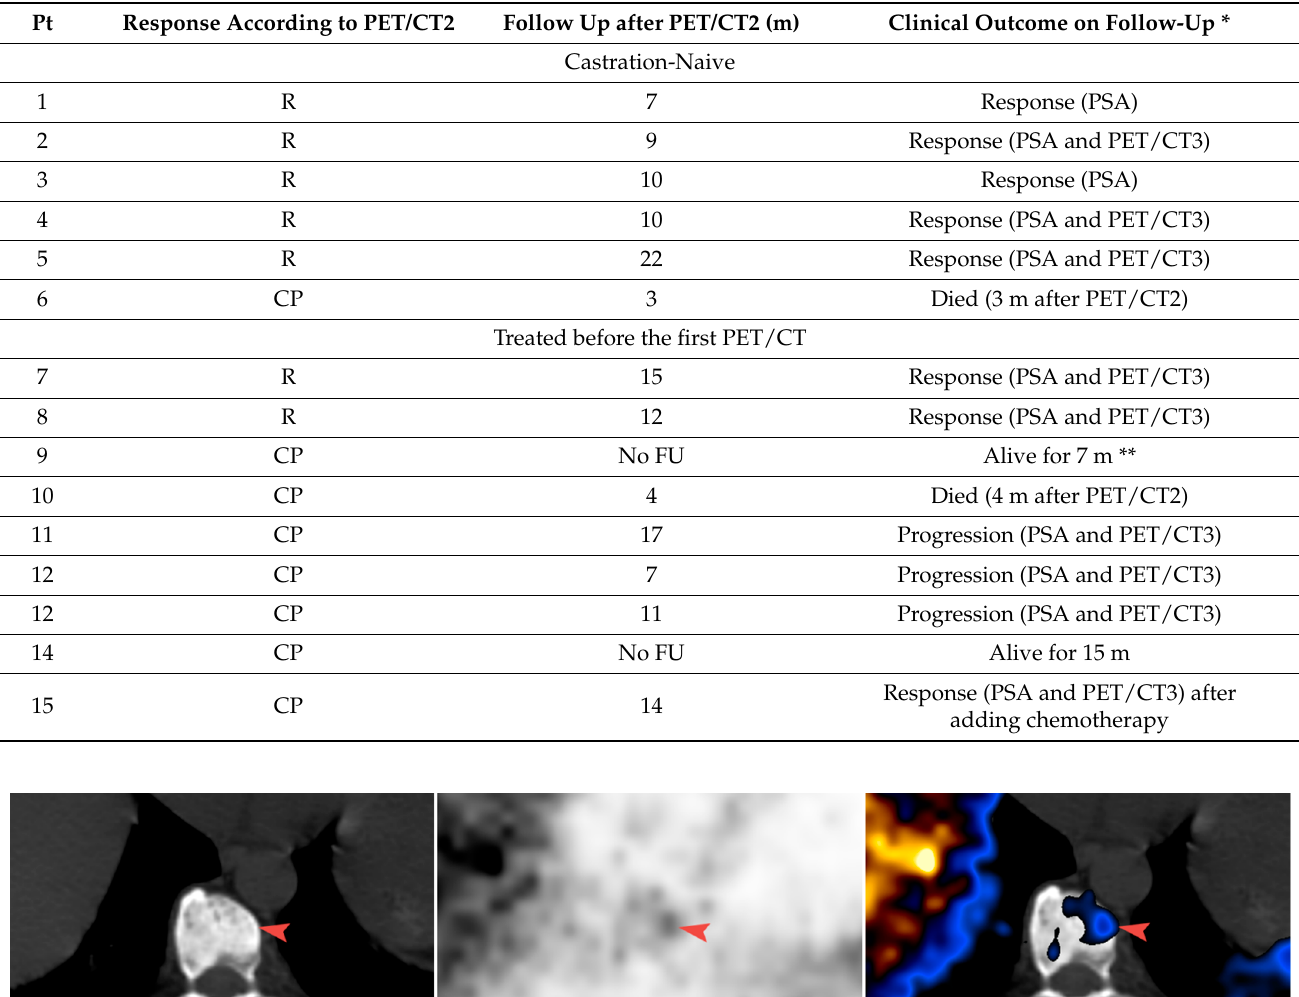
Table 2. Clinical outcome on follow-up. pt, patients; m, months; CP, clinical progression; R, response to therapy; PSA, prostate-specific antigen. * In 9 patients a third PET/CT scan was performed and their findings were included in response assessment. ** Patients 9 and 14 were lost to detailed follow-up and the only data available was that there were alive.